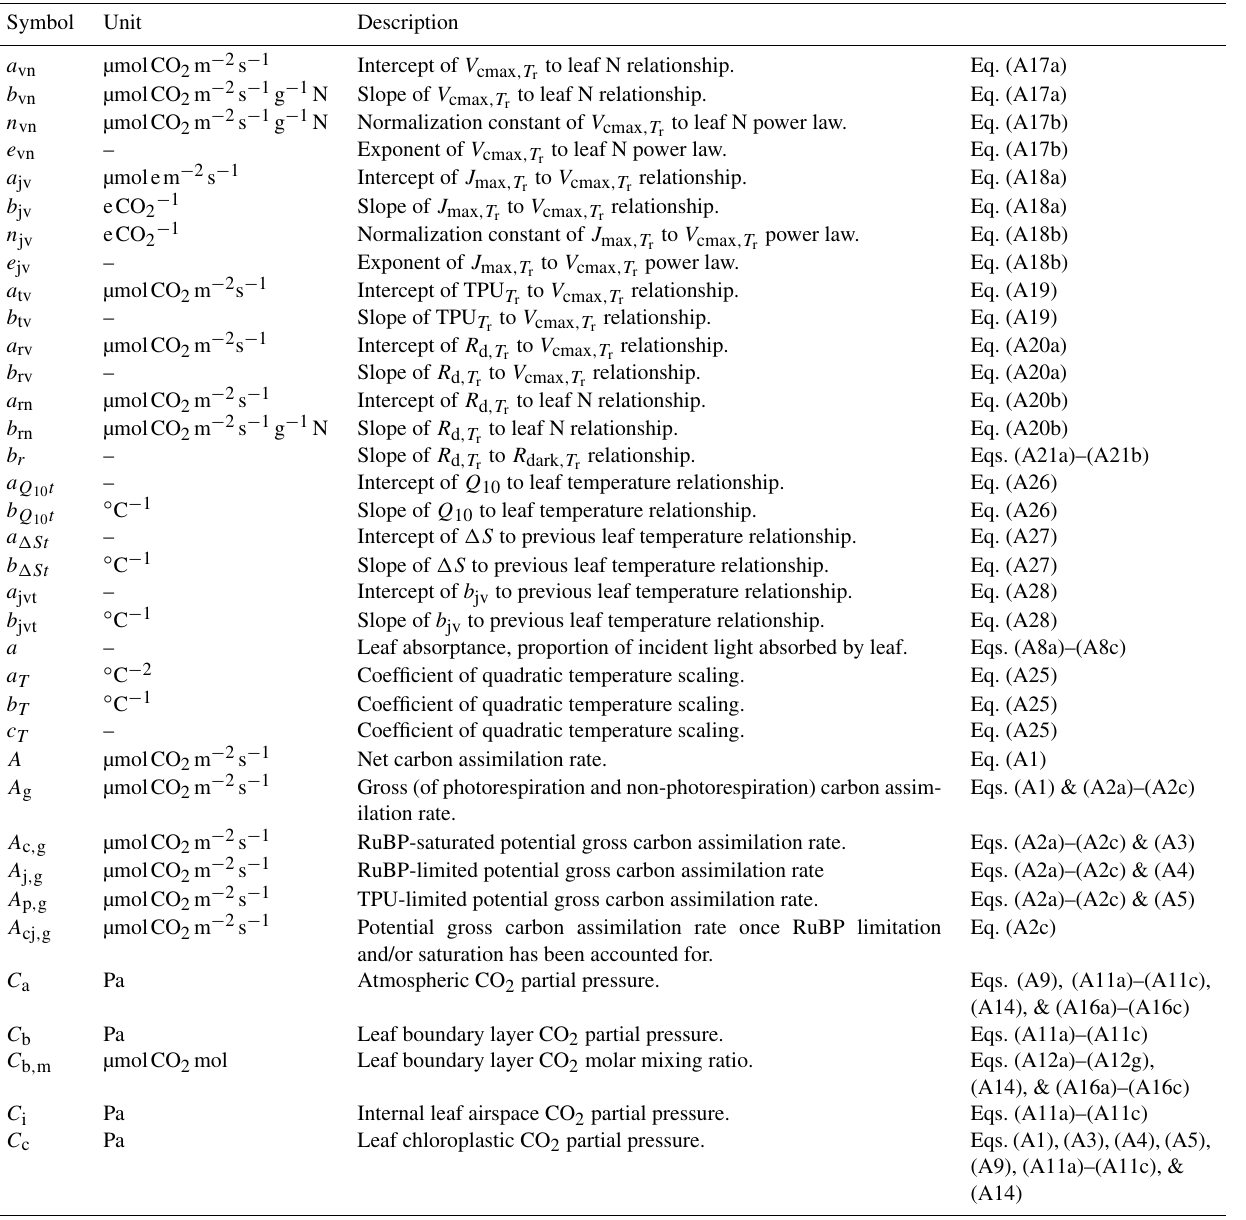
Table A1. Table of notations. Symbol Unit Description